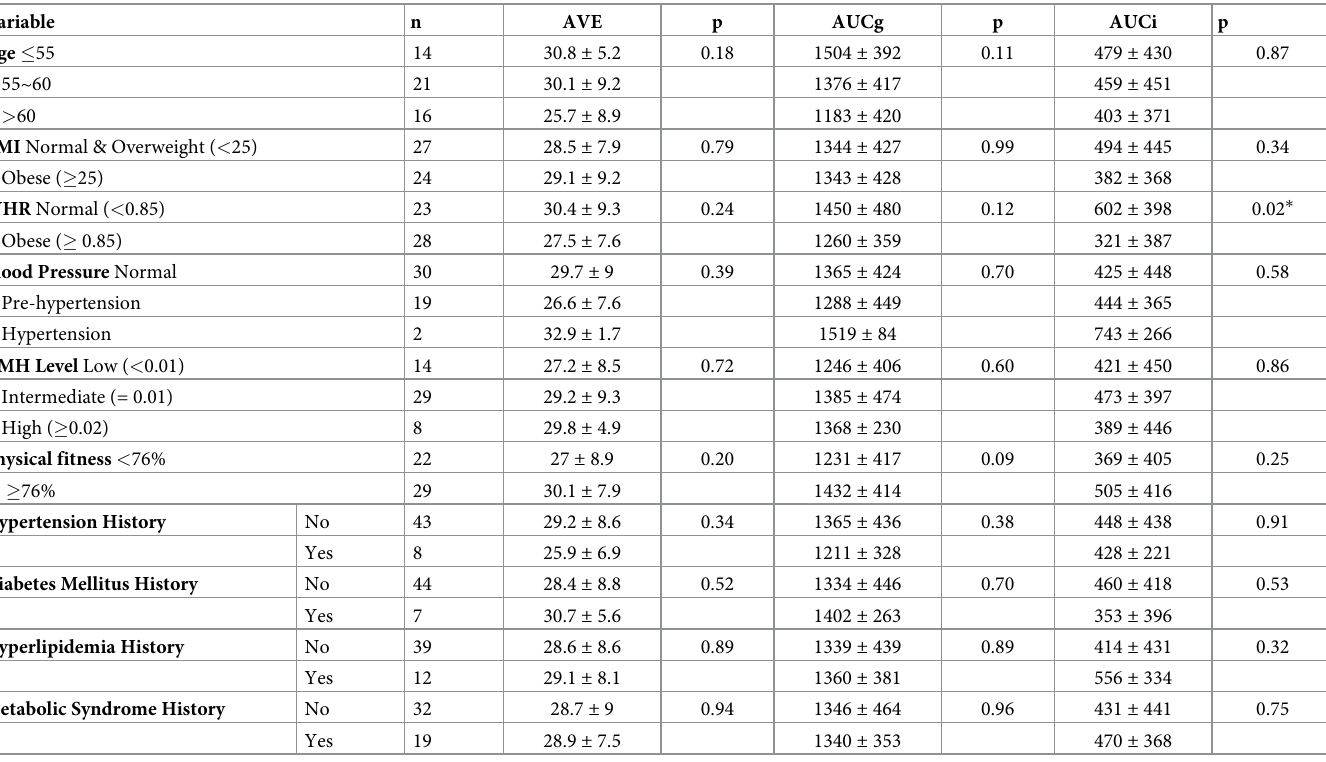
Table 3. Differences in CAR based on individual characteristics after the marine healing program.